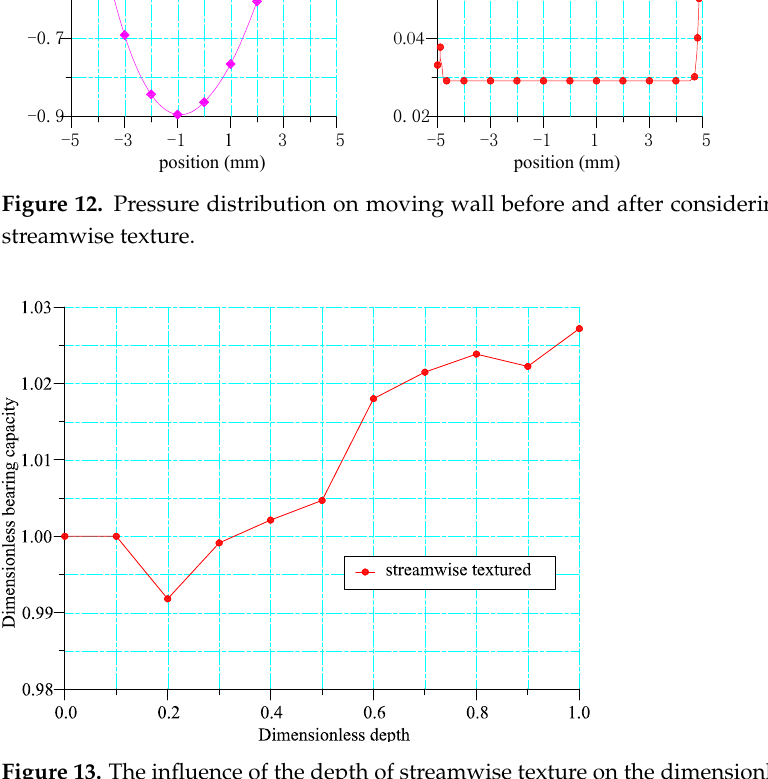
Figure 13. The influence of the depth of streamwise texture on the dimensionless LCC.